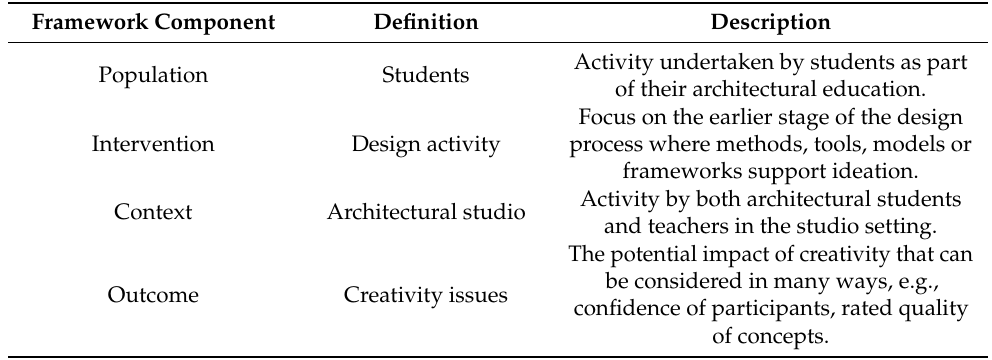
Activity undertaken by students as part of their architectural education. Focus on the earlier stage of the design process where methods, tools, models or frameworks support ideation. Activity by both architectural students and teachers in the studio setting. The potential impact of creativity that can be considered in many ways, e.g., confidence of participants, rated quality of